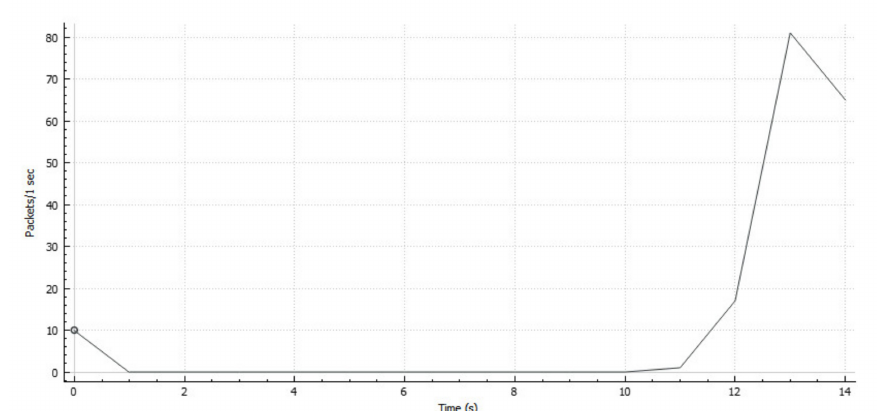
Figure 4. The generalized experiment design.